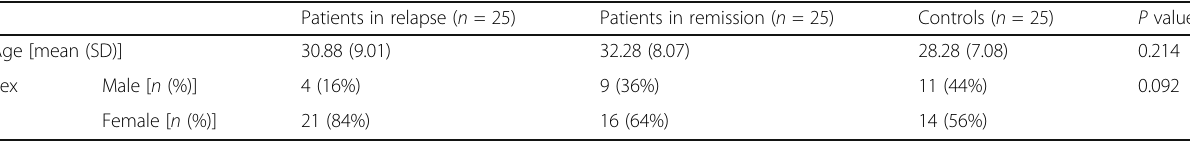
Table 1 Demographics of MS patients and control group Patients in relapse ( n = 25) Patients in remission ( n = 25)